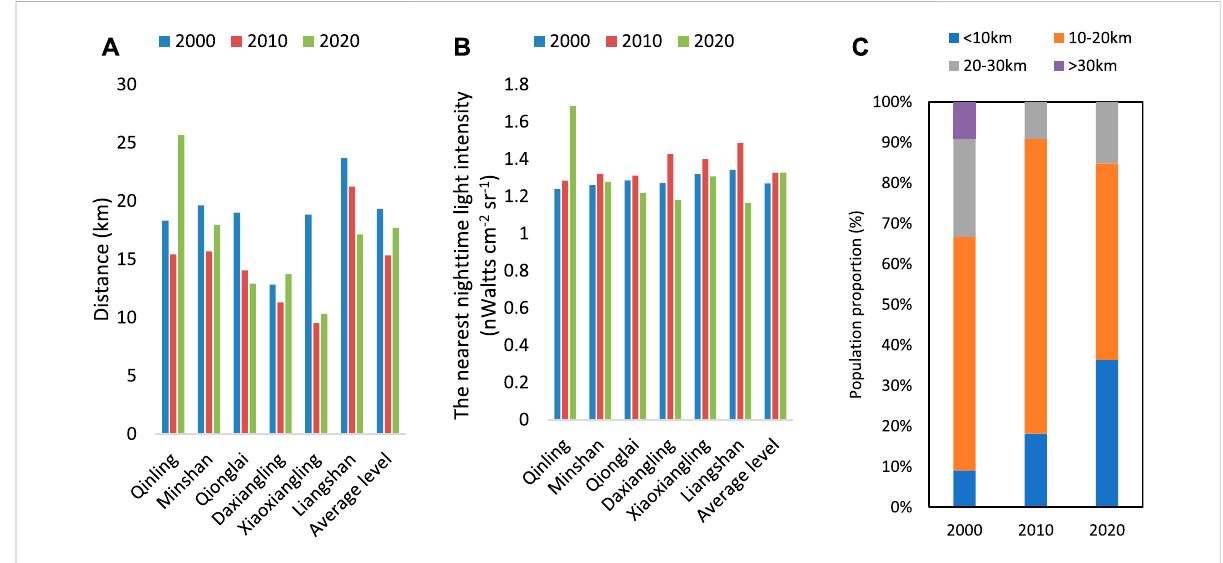
FIGURE 6 Changes of the distance from nighttime light to giant panda populations and light intensity. (A) The shortest distance from nighttime light to panda populations in of different mountains; (B) The intensity of the nearest nighttime light of panda populations in different mountains; (C) Proportions of panda populations with different distances from the light source in each